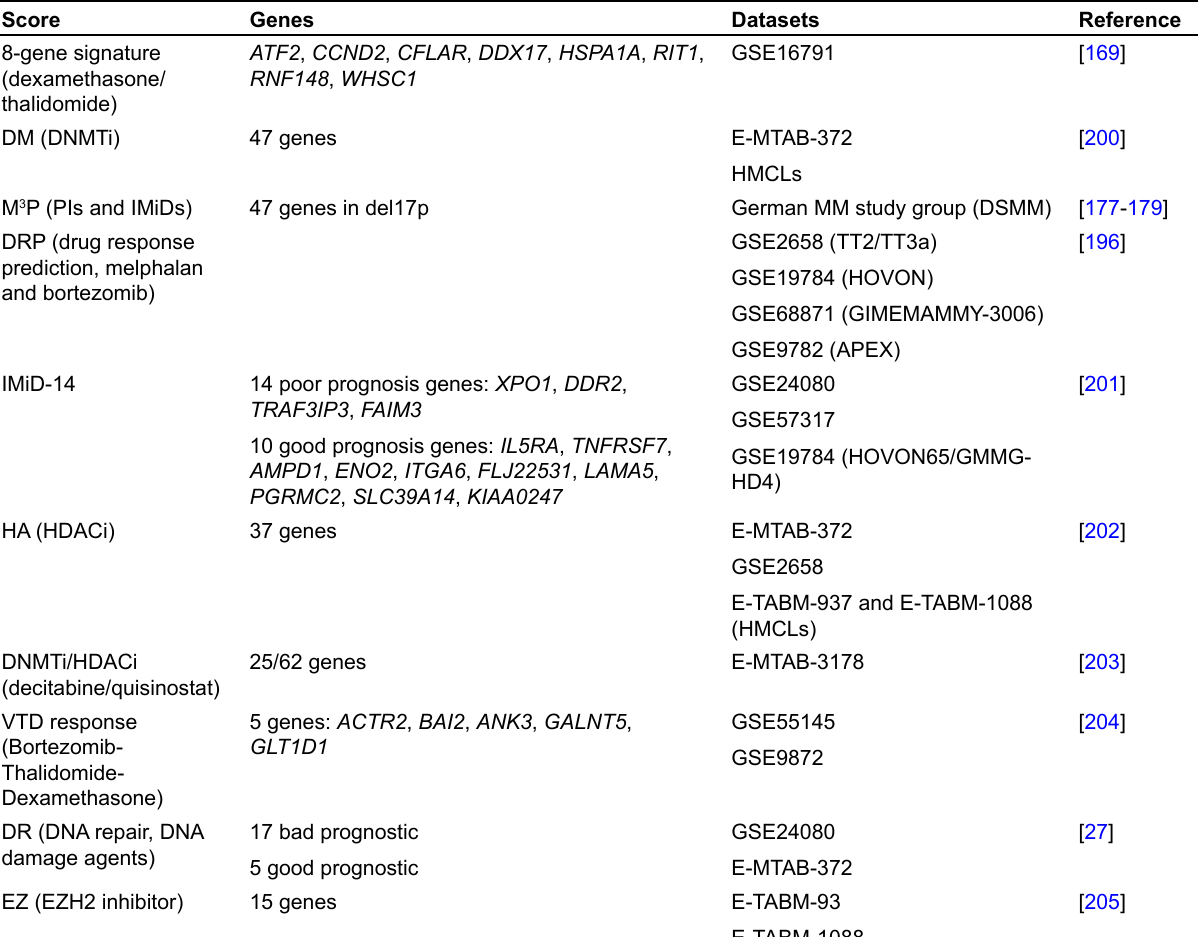
Table 4. Drug response-scores based on GEP Score